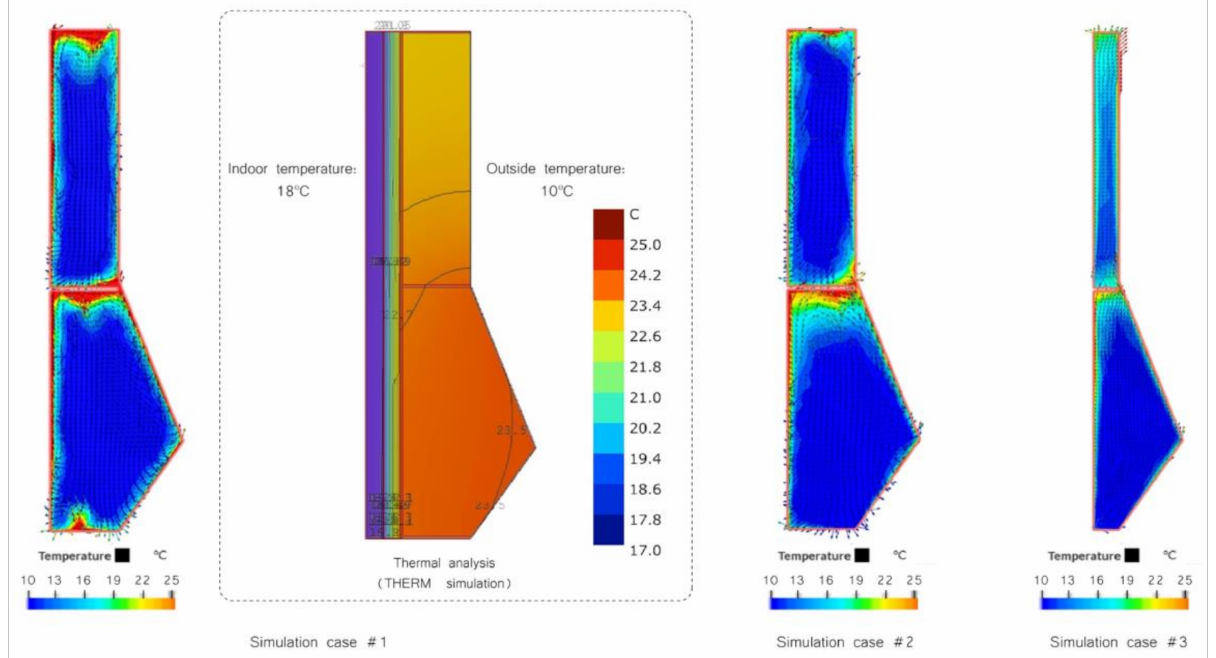
Figure 25. Convective heat transfer analysis simulation results for the winter